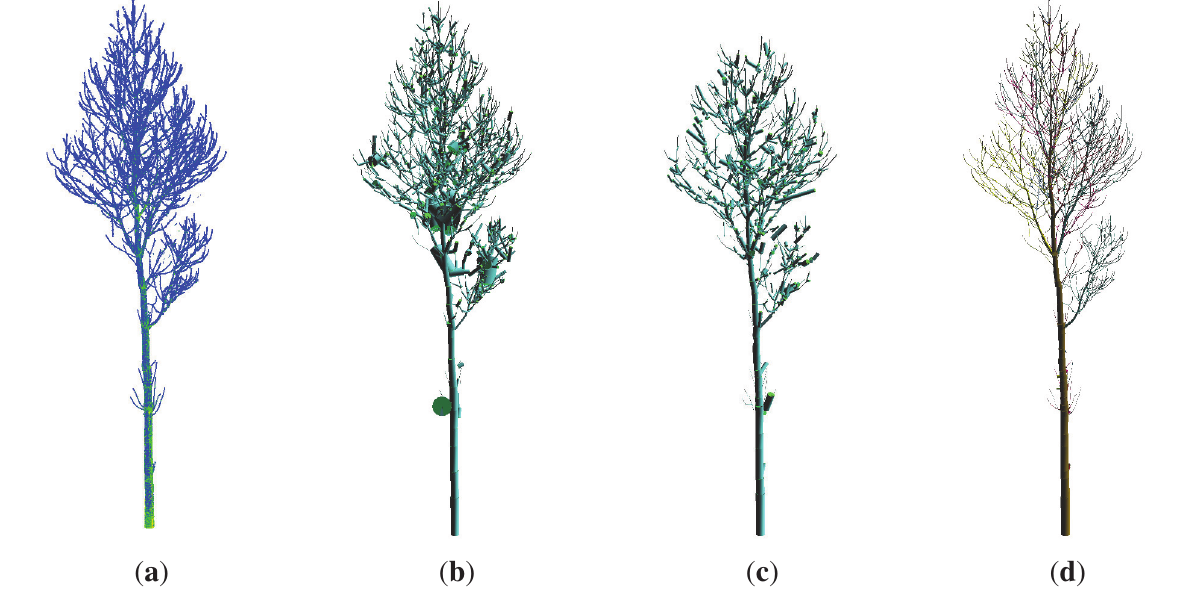
Impact on the selection of different circle fitting methods of tree #1 (height ≈ 12 m): (a) the input point cloud of Tree 1; colors represent (unused) intensity values; (b) a model derived by the NLS method with large failure cylinders; (c) a model derived by the plane fitting method with failure cylinders; (d) a model derived by the quantile method covering the complete input point cloud without errors, with successfully detected stem and branches colored